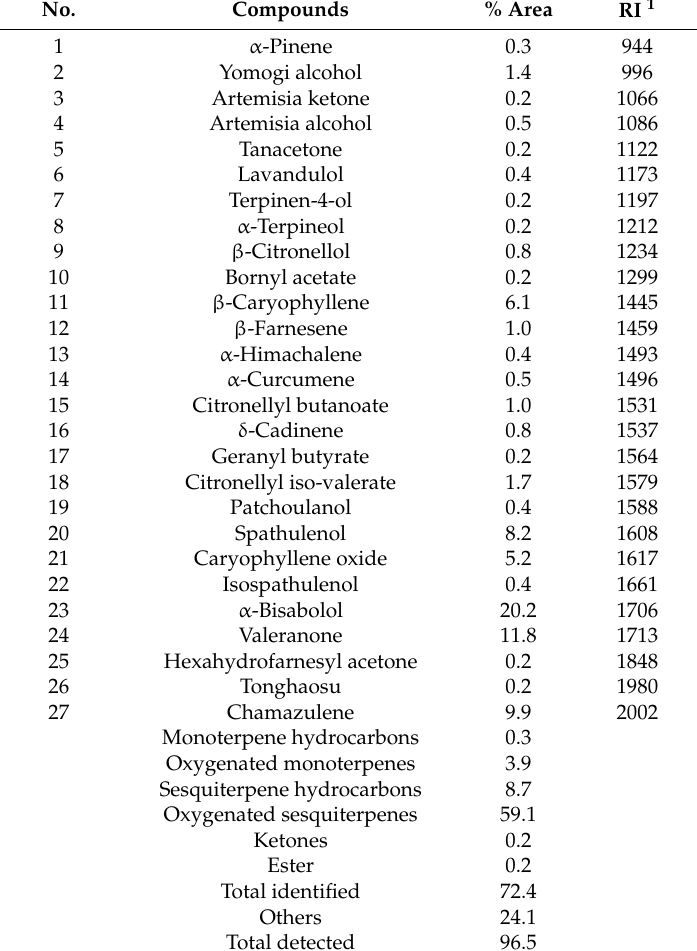
Table 1. Chemical composition of the essential oil of W. glabra from Tibet.